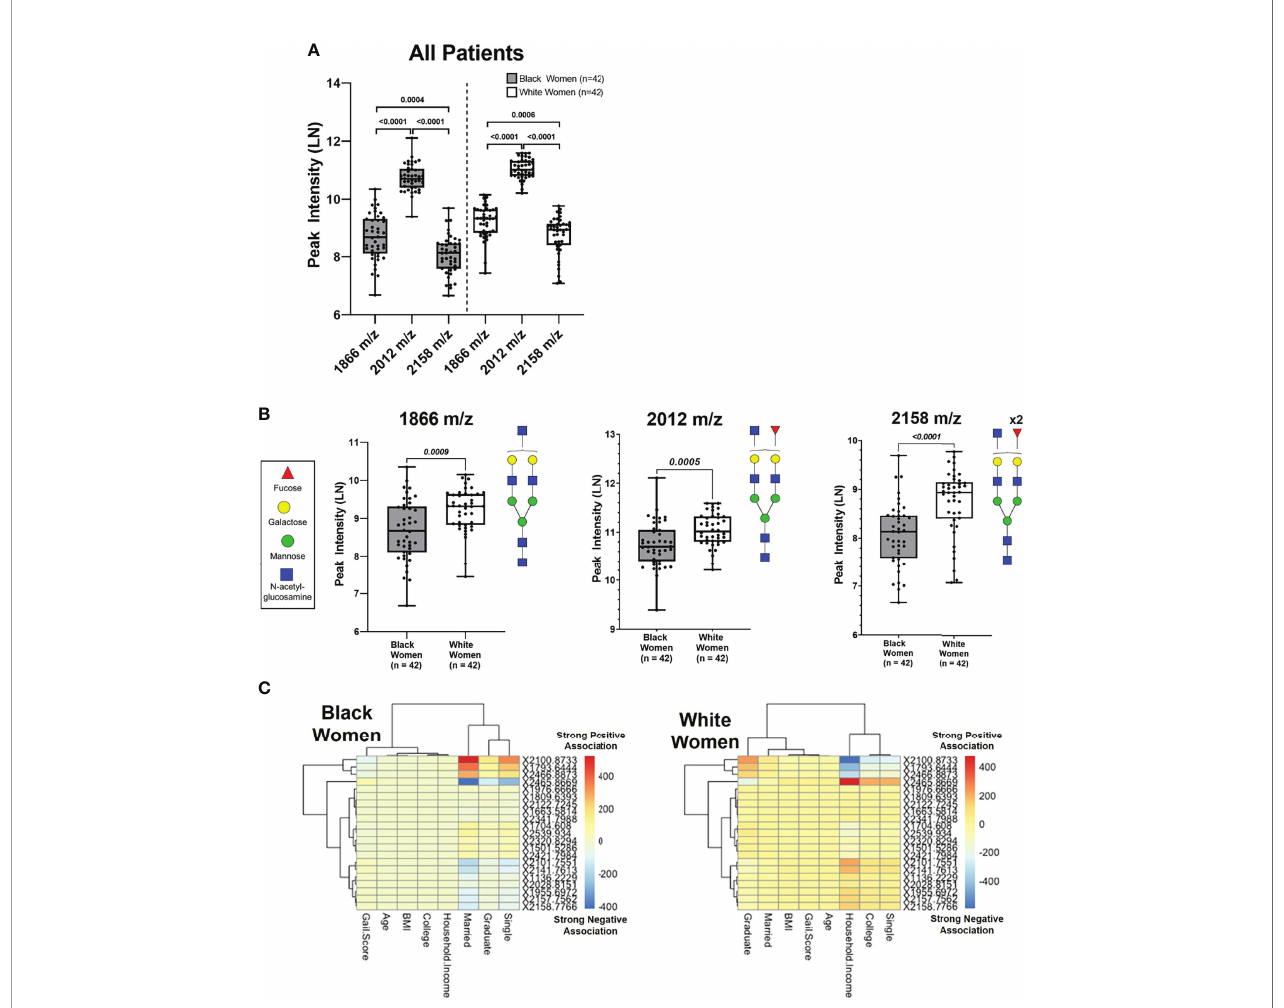
FIGURE 2 | Unique N-Glycan peak intensity patterns are associated with Black women and white women. (A) Peak intensities of N-glycans 1866 m/z, 2012 m/z and 2158 m/z analyzed from Black and White women. Each data point represents a patient (Black n=42 and White n=42). (B) Comparison of N-glycan peak intensi fi es show white women have higher intensi fi es compared to Black women for peaks 1866 m/z (p= 0.0009), 2012 m/z (p=0.0005) and 2158 m/z (p < 0.001) (C) Linear regression model with ancestry as group variable & socioeconomic covariates as predictors (p <0.0001). The numbers 400 (Strong Negative Association) on the color bar indicate the values of the regression coef fi